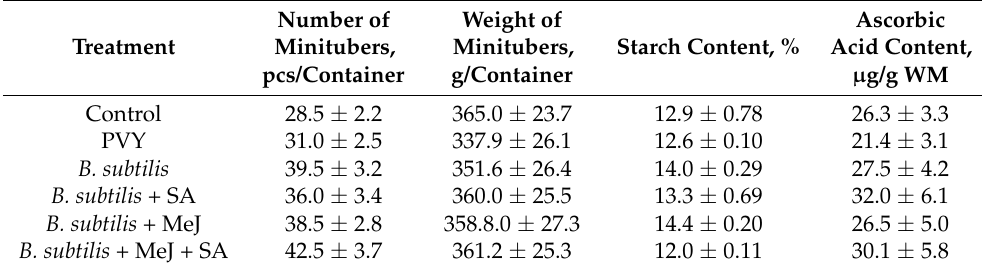
Table 2. Effect of PVY infection and the mixture of B. subtilis with SA and MeJ application under soil water deficiency on productivity and quality of